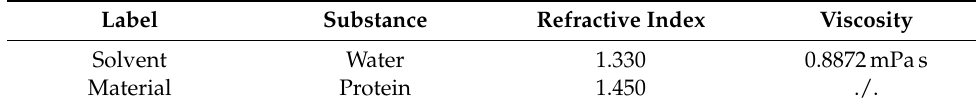
Table 2. Materials properties for the analysis model of zetasizer software at